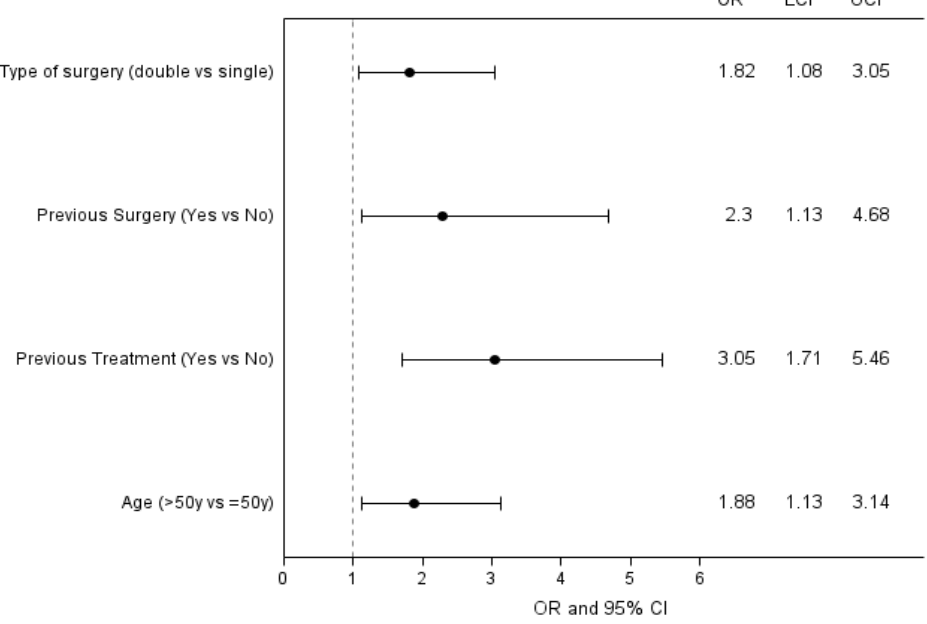
Figure 5. Forest plot for Complications in association with prognostic factors significant in the multivariable model; y =